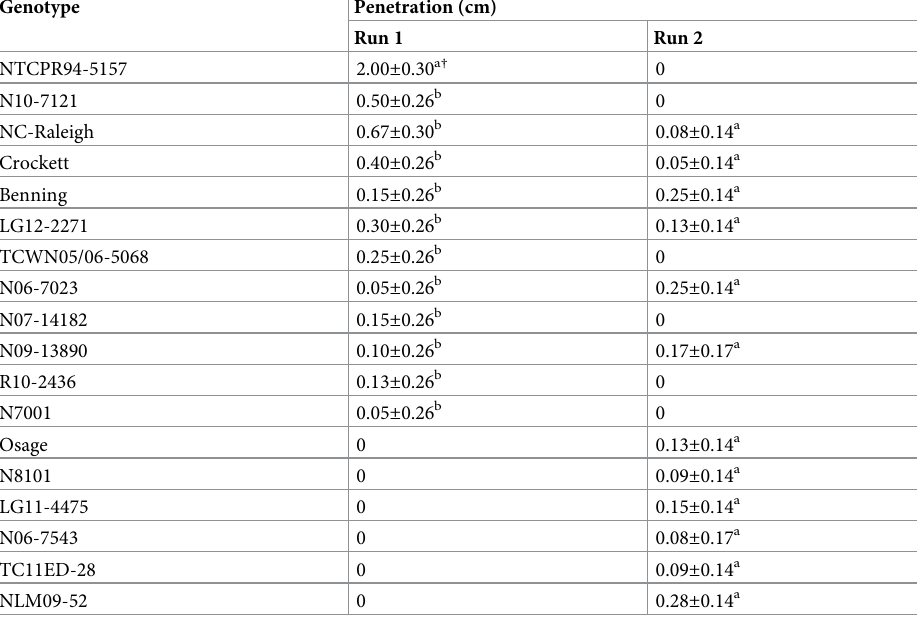
† Mean ± standard error. Values followed by different letters are significantly different according to a LSD test at P <